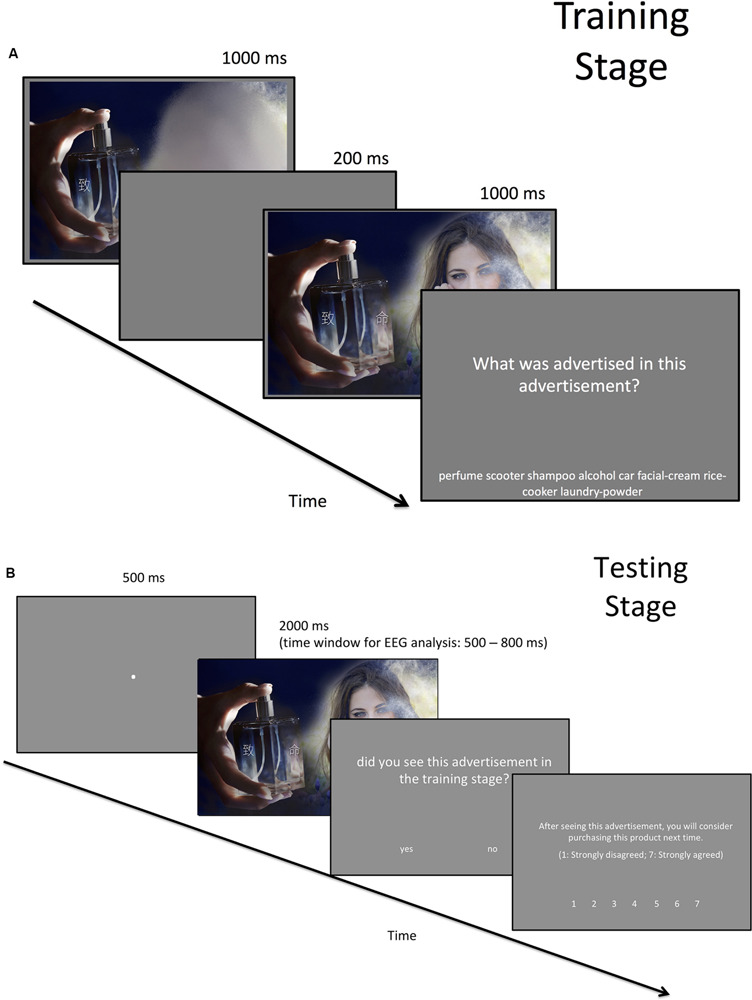
Stimuli used in the (A) training stage and (B) testing stage for Experiment 3. The presentation of the advertisement was separated into two intervals. In the first interval, the endorser’s image was blurred in order to attract the participant’s attention when the blurry part became clear in the second interval. All text was shown in Chinese in the actual experiment.